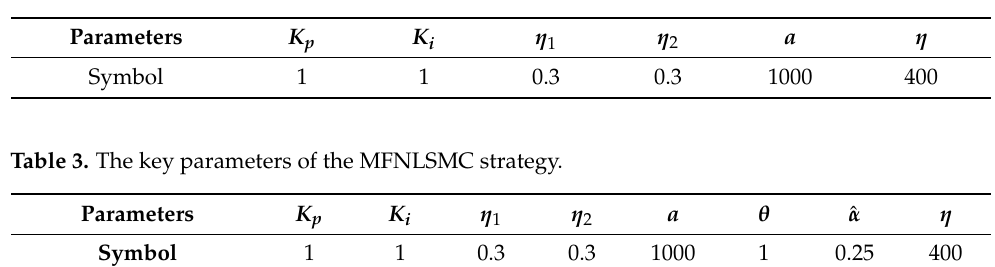
Table 2. The key parameters of the MFSMC strategy.